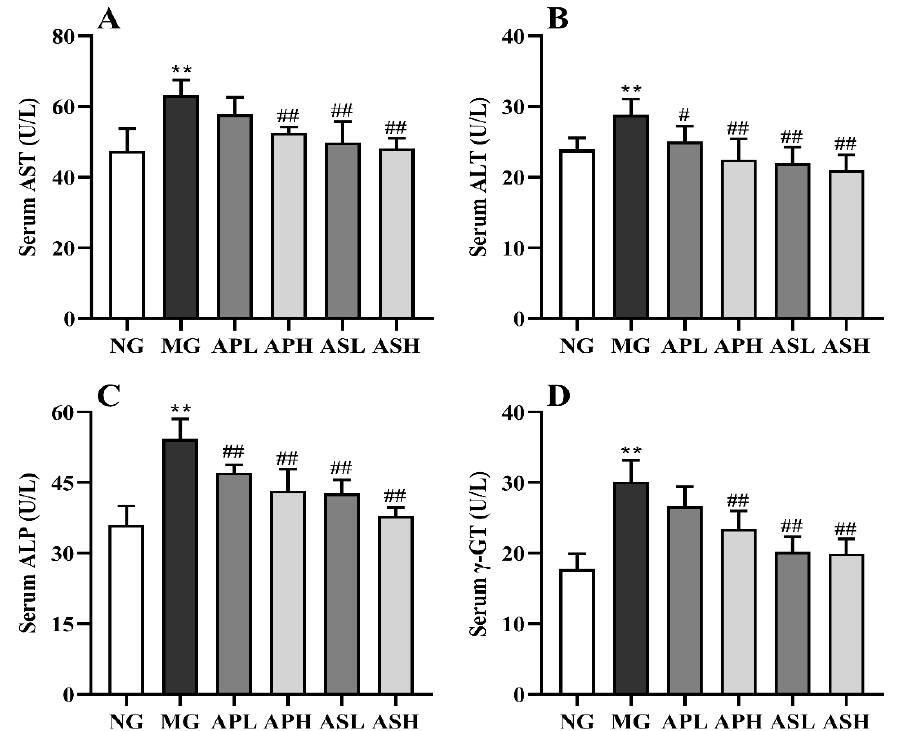
Figure 3. Effect of AP and AS on the hepatic function in ALD mice. ( A ) Serum AST; ( B ) Serum ALT; ( C ) Serum ALP; ( D ) Serum γ-GT. Data are expressed as mean ± SD ( n = 12). ** p < 0.01, vs. NG; # p < 0.05, ## p < 0.01, vs. MG.